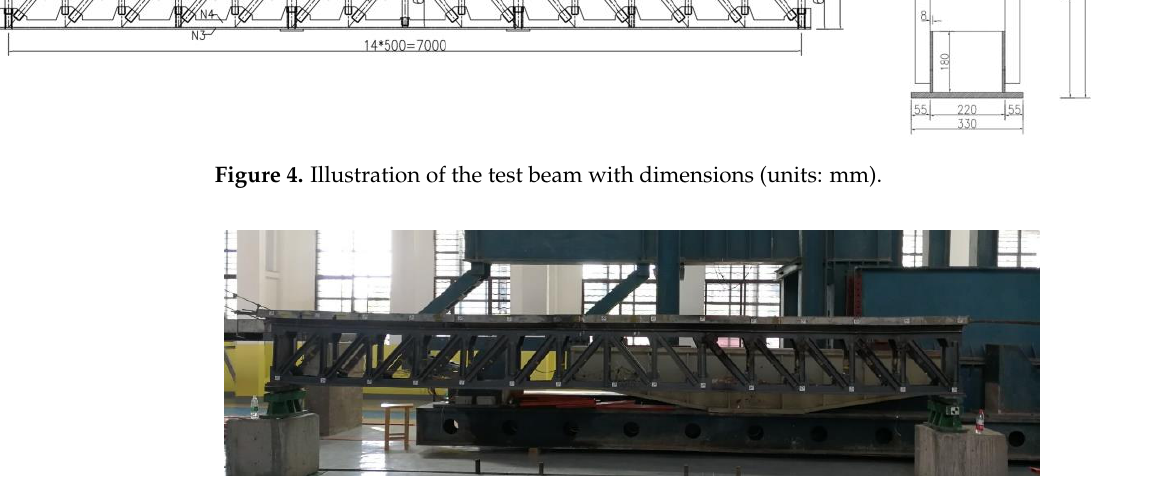
Figure 5. Photograph of the test beam.